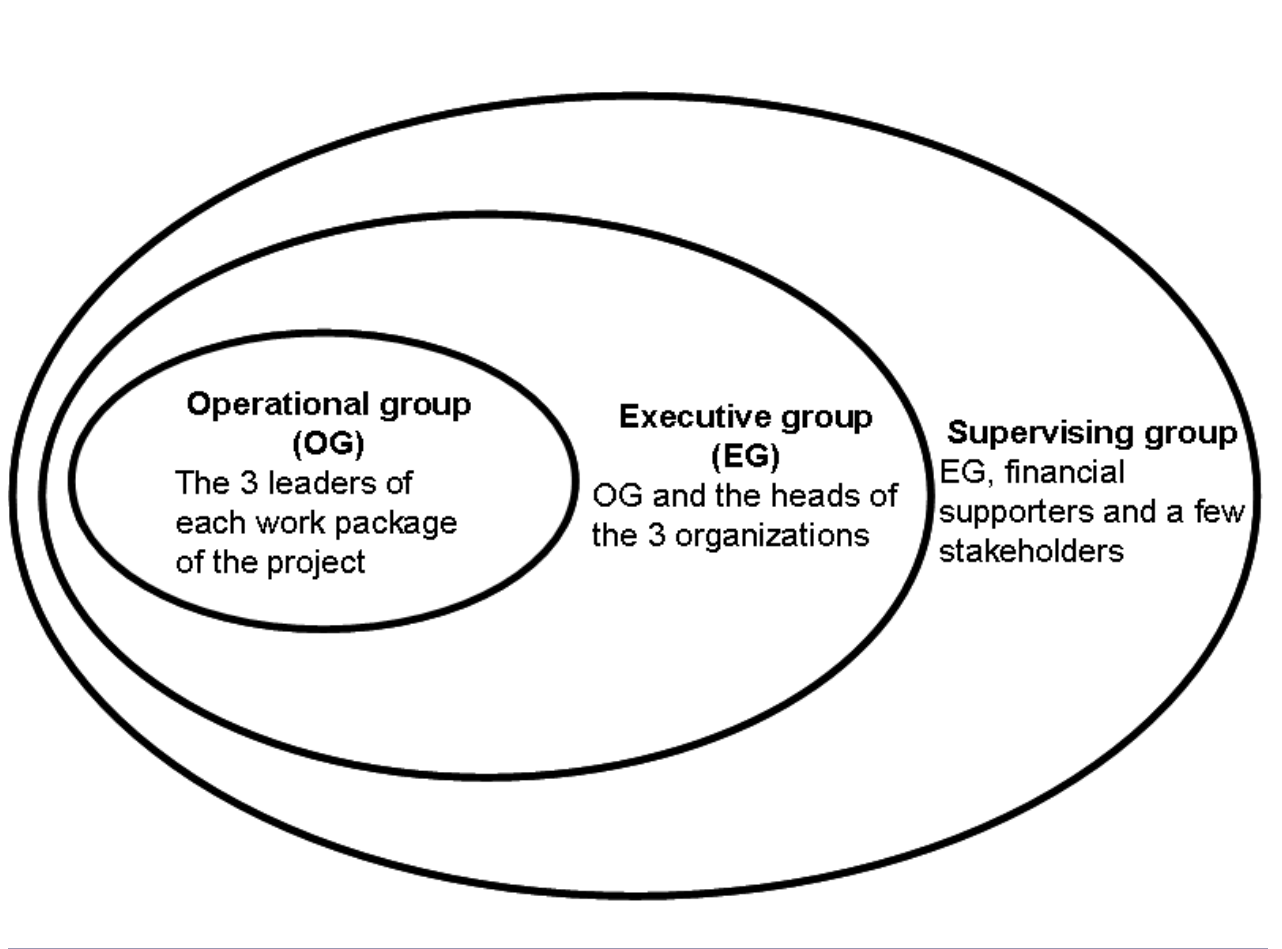
Fig. 3. Coordination of the Ecovars